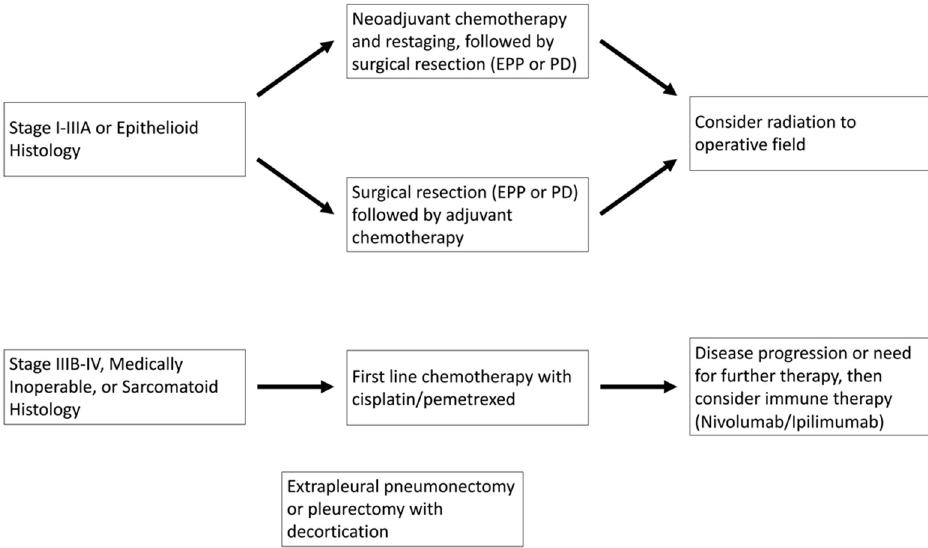
Figure 1. Current treatment algorithm for malignant mesothelioma. EPP, extrapleural pneumonec- tomy; PD, pleurectomy with decortication.